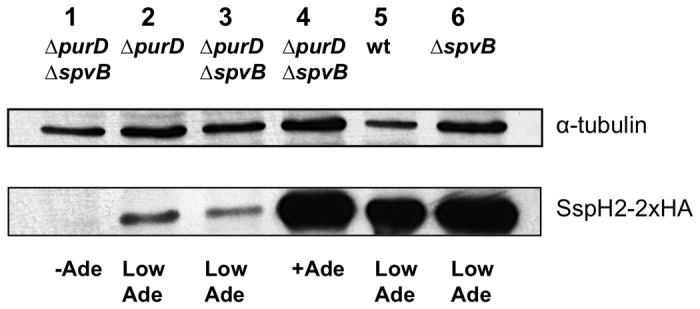
Protein induction and secretion of wt, ∆purD and/or ∆spvB strains.HeLa cells were infected with Salmonella strains in the presence of normal concentration of adenine. 2 h after salicylate induction, the adenine concentration was limited in lanes 2, 3, 5 and 6 (Ade) and normal in lane 4 (+Ade). Sample in lane 1 served as a control with no adenine added (-Ade). Strains in lane 1: MPO325; 2: MPO305; 3: MPO325; 4: MPO325; 5: 14028; 6: MPO302.